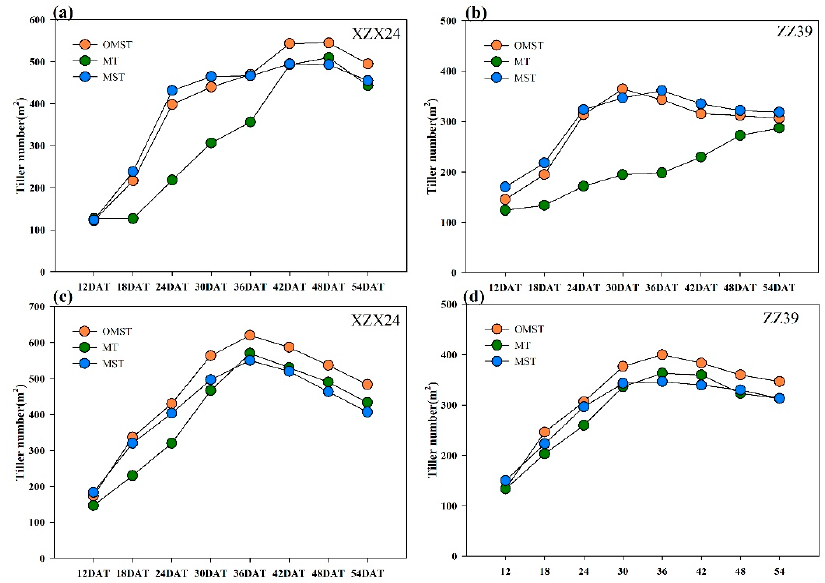
Figure 7. The tillering dynamics of different rice establishment methods: ( a , b ) 2021; and ( c , d ) 2022. OMST: Orderly mechanical seedling throwing, MT: Manual transplanting, MST: Manual seedling throwing, XZX24: Xiangzaoxian24, ZZ39: Zhongzao39, DAT: Days after transplanting.